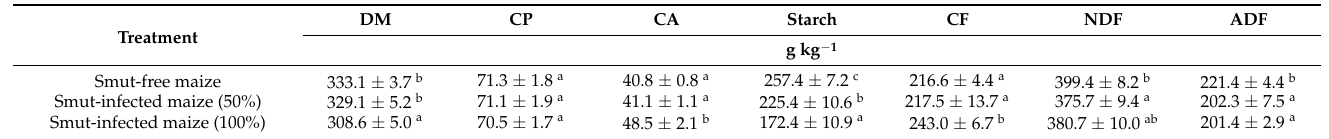
Table 1. DM and chemical composition (DM basis) of freshly chopped whole-plant corn with different Ustilago maydis infection rate (before ensiling).